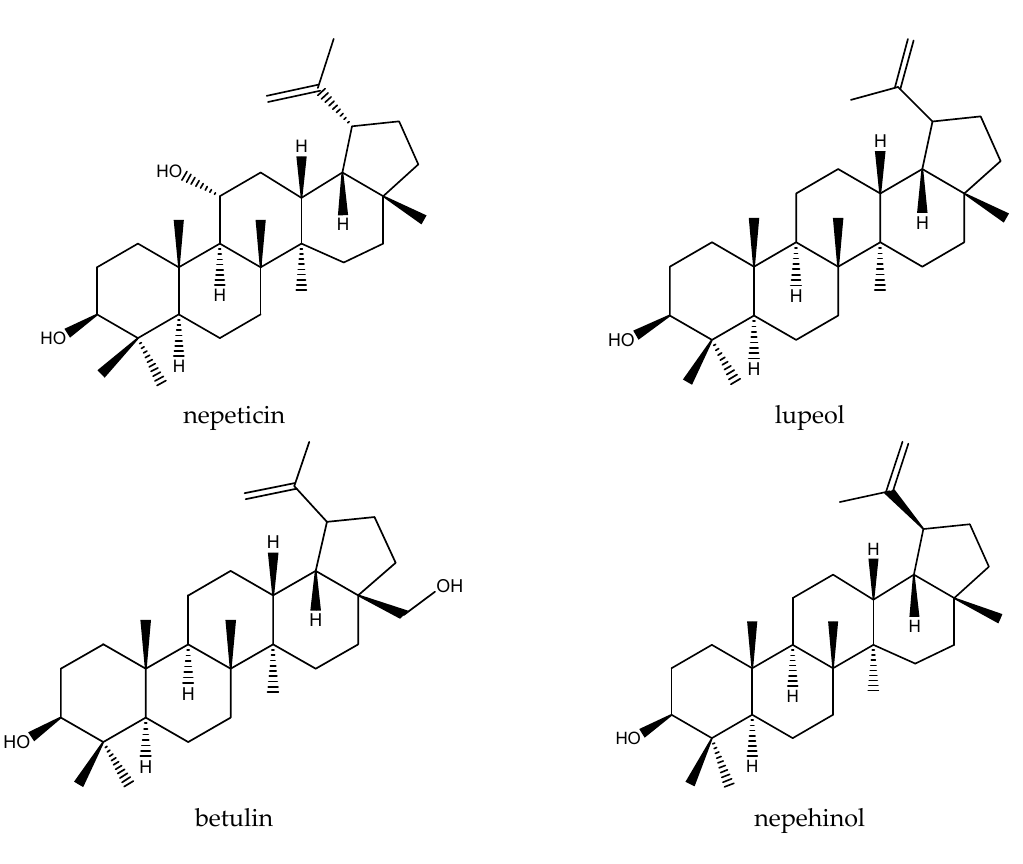
Figure 4. Chemical structure of some important triterpenes defined in genus Nepeta. Figure 5. Chemical structure of some important triterpenes defined in genus Nepeta